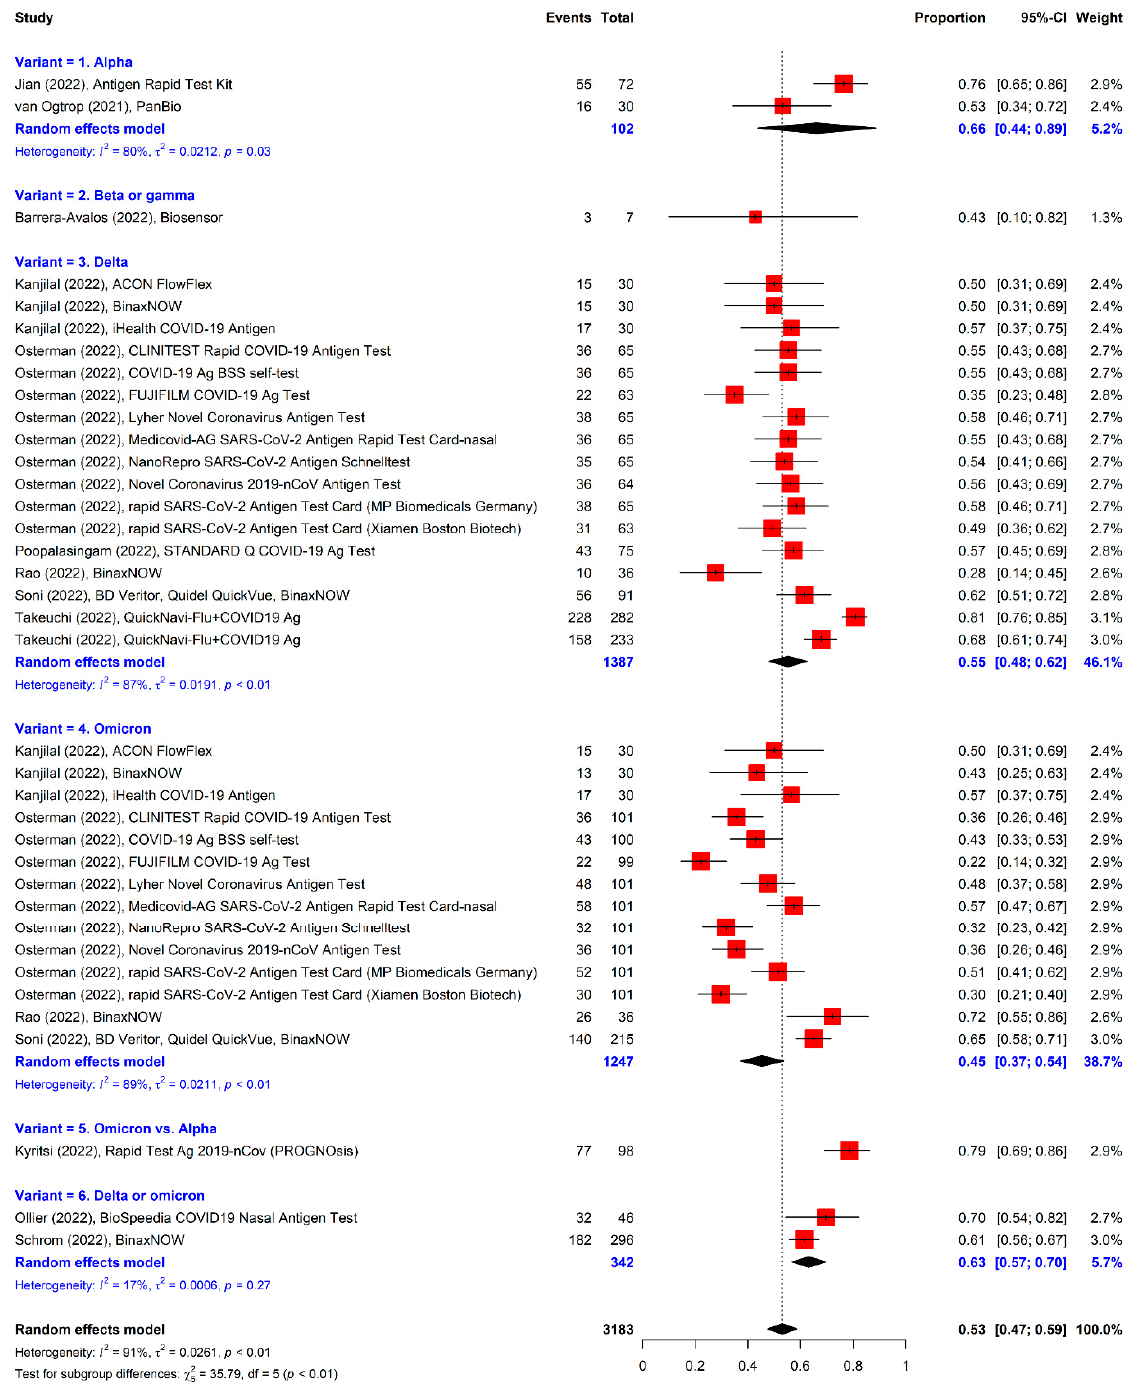
Figure 9. Forest plot for combining the formal and additional studies of RATs. The estimated pooled values of subgroups are presented in blue color.